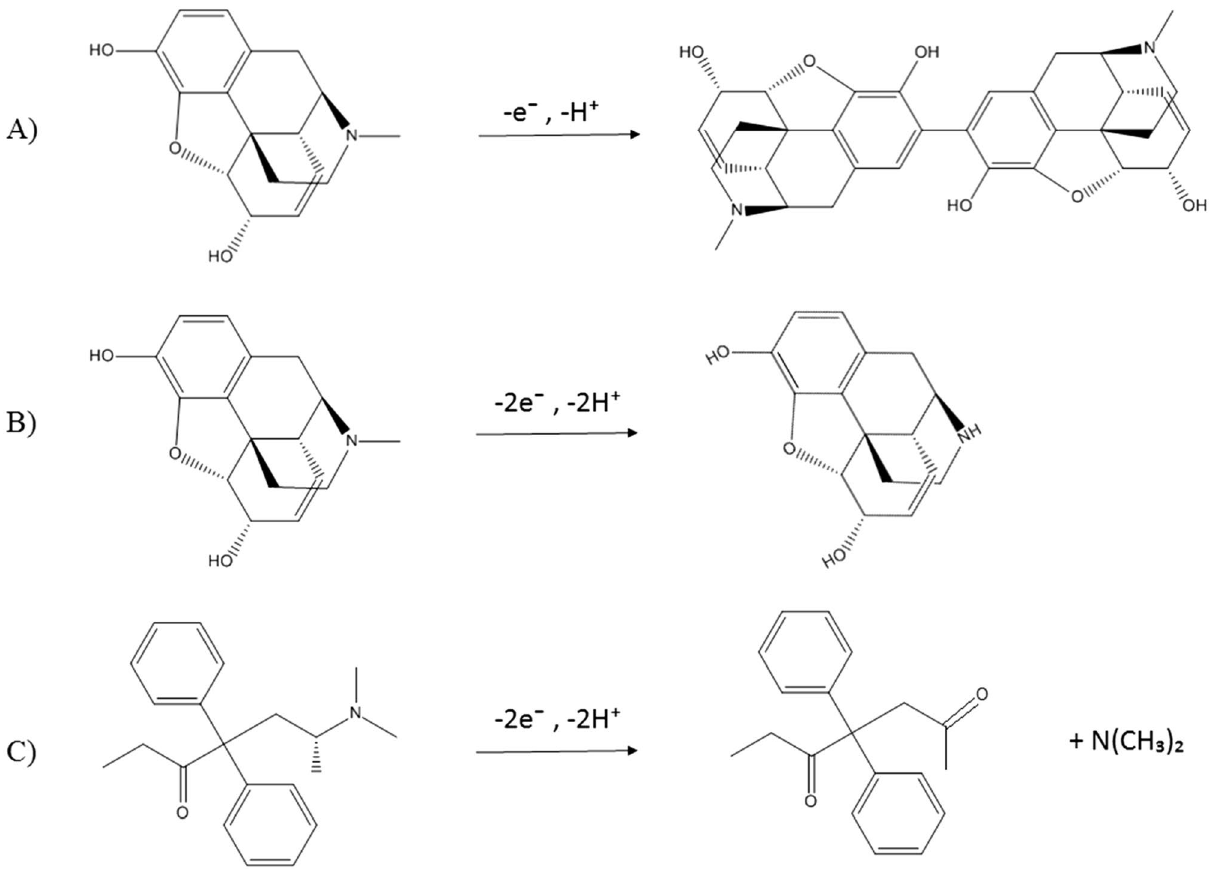
Figure 1. Electrochemical reaction of morphine and